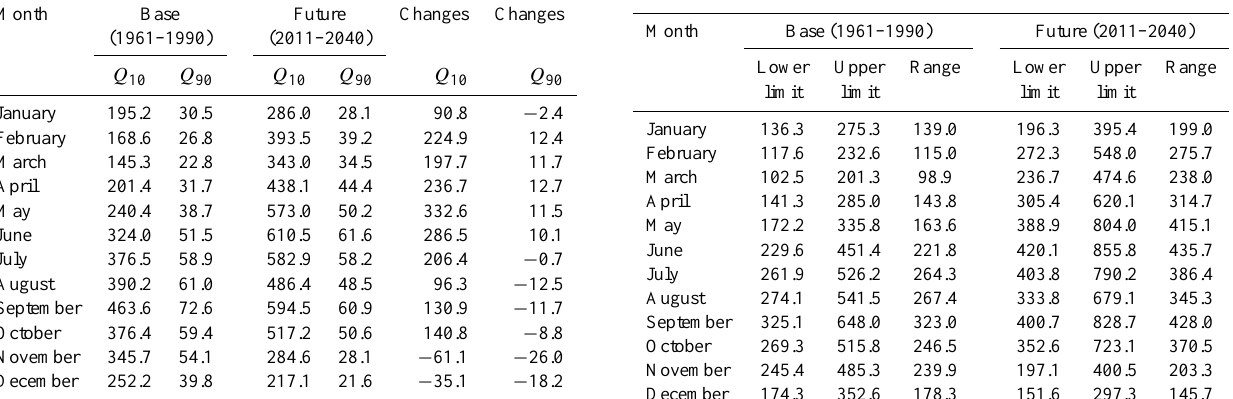
Table 4. Mean flows (m − 3 s − 1 ) with 10% ( Q 10 ) and 90% ( Q 90 ) permanence during the base period (1961–1990) and future period (2011–2040), Santo Ângelo gauge station.